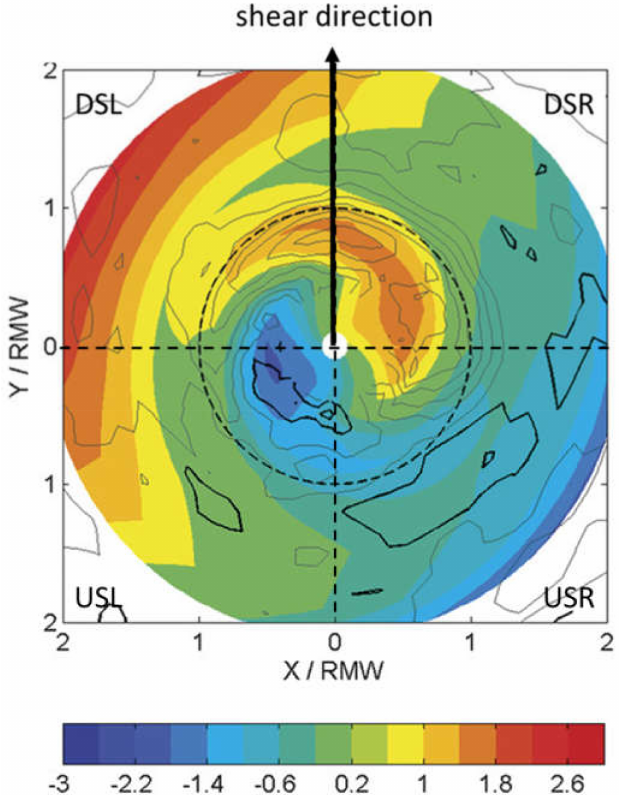
Figure 13. ( a ) Plots of the wavenumber-1 component of equivalent potential temperature (shaded; K) at 50 m from dropsondes and contours of vertical velocity measured by TDR (contours, 0.2 m s − l contour interval) at 1.5 km ltitude. Gray contours represent updrafts and black contours represent downdrafts. Shear direction is shown by the black arrow. The thick dashed black line represents the radius of maximum wind speed. Adapted from